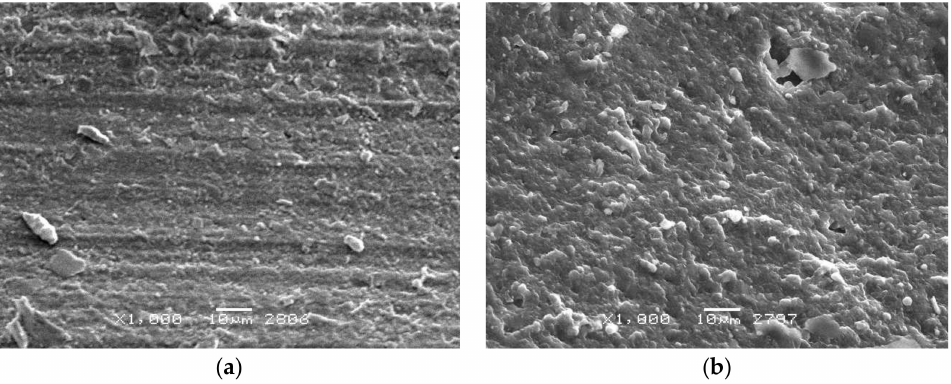
Figure 9. Sample surface—material: NBR ( a ) before the test; ( b ) after the test.